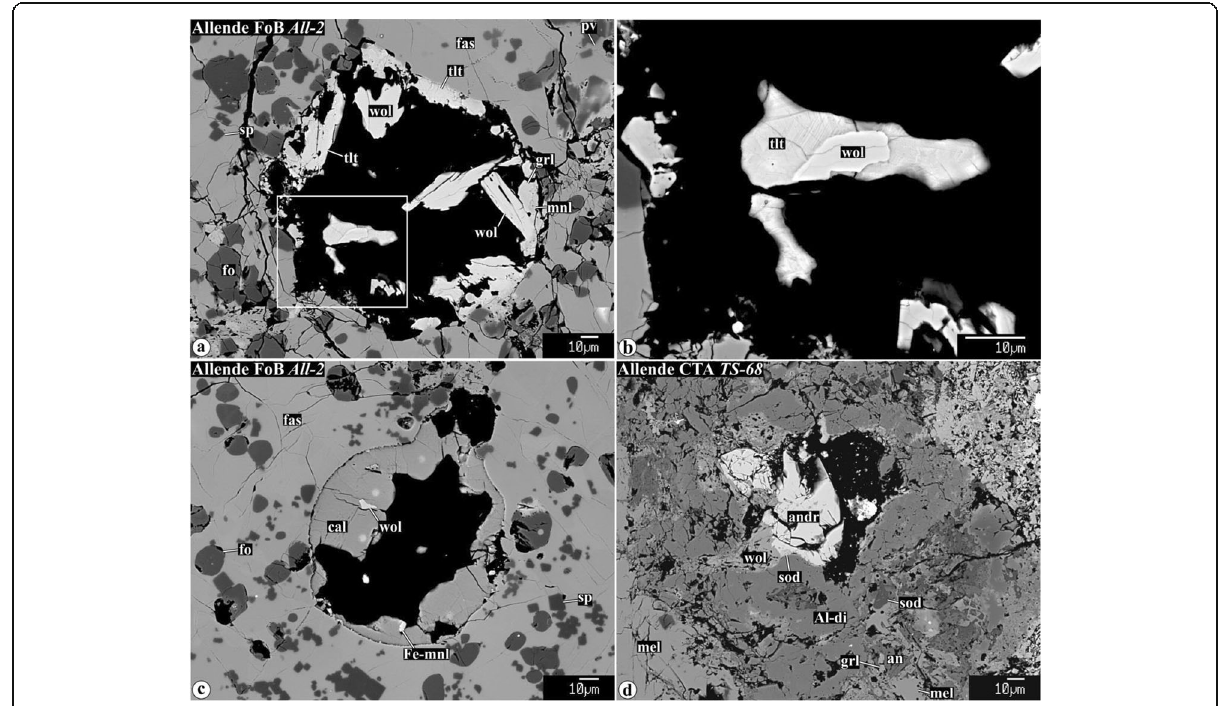
Fig. 12 Secondary minerals growing in voids inside coarse-grained Allende CAIs. Region outlined in a is shown in detail in